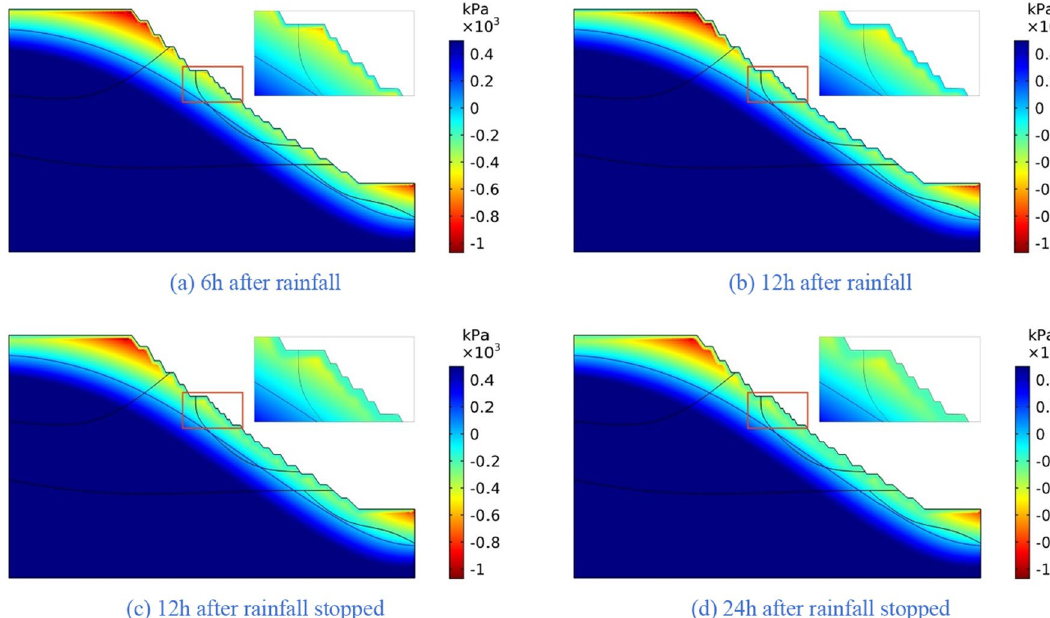
Figure 15. The pore-water pressure distribution (Scheme I).